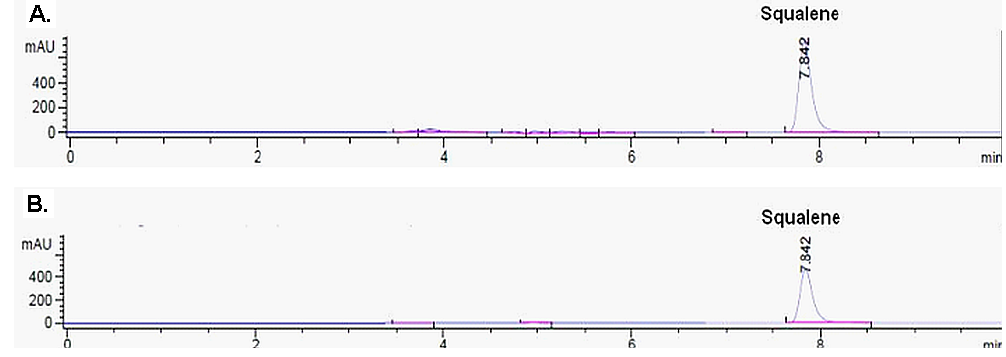
Figure 4. Squalene content of amaranth oil extracted with hexane without (A) and with (B) application of heat, determined by